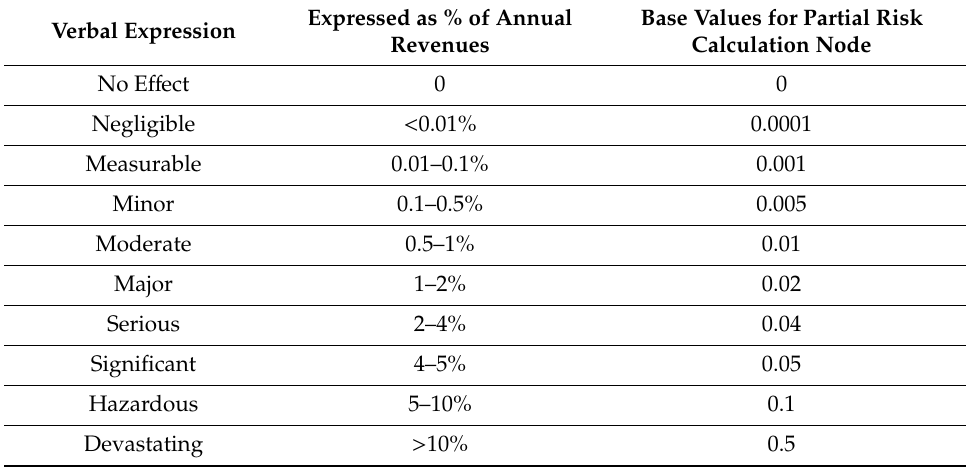
Table 4. Discrete classes of the “Severity of Impacts on Subsystems”, “Partial Risk”, “Subsystem Risk”, and “Total Risk” nodes used in the discrete model (expressed as percentage loss of annual